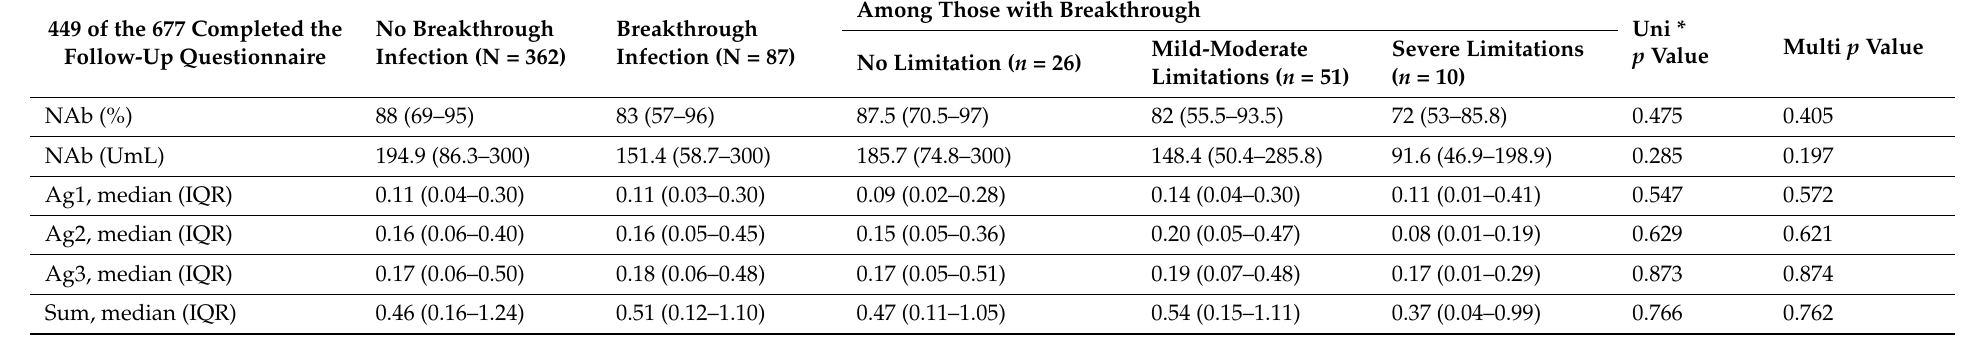
Table 2. Median (IQR) values for the measured assays for participants with or without breakthrough infections including all vaccination and previous infection